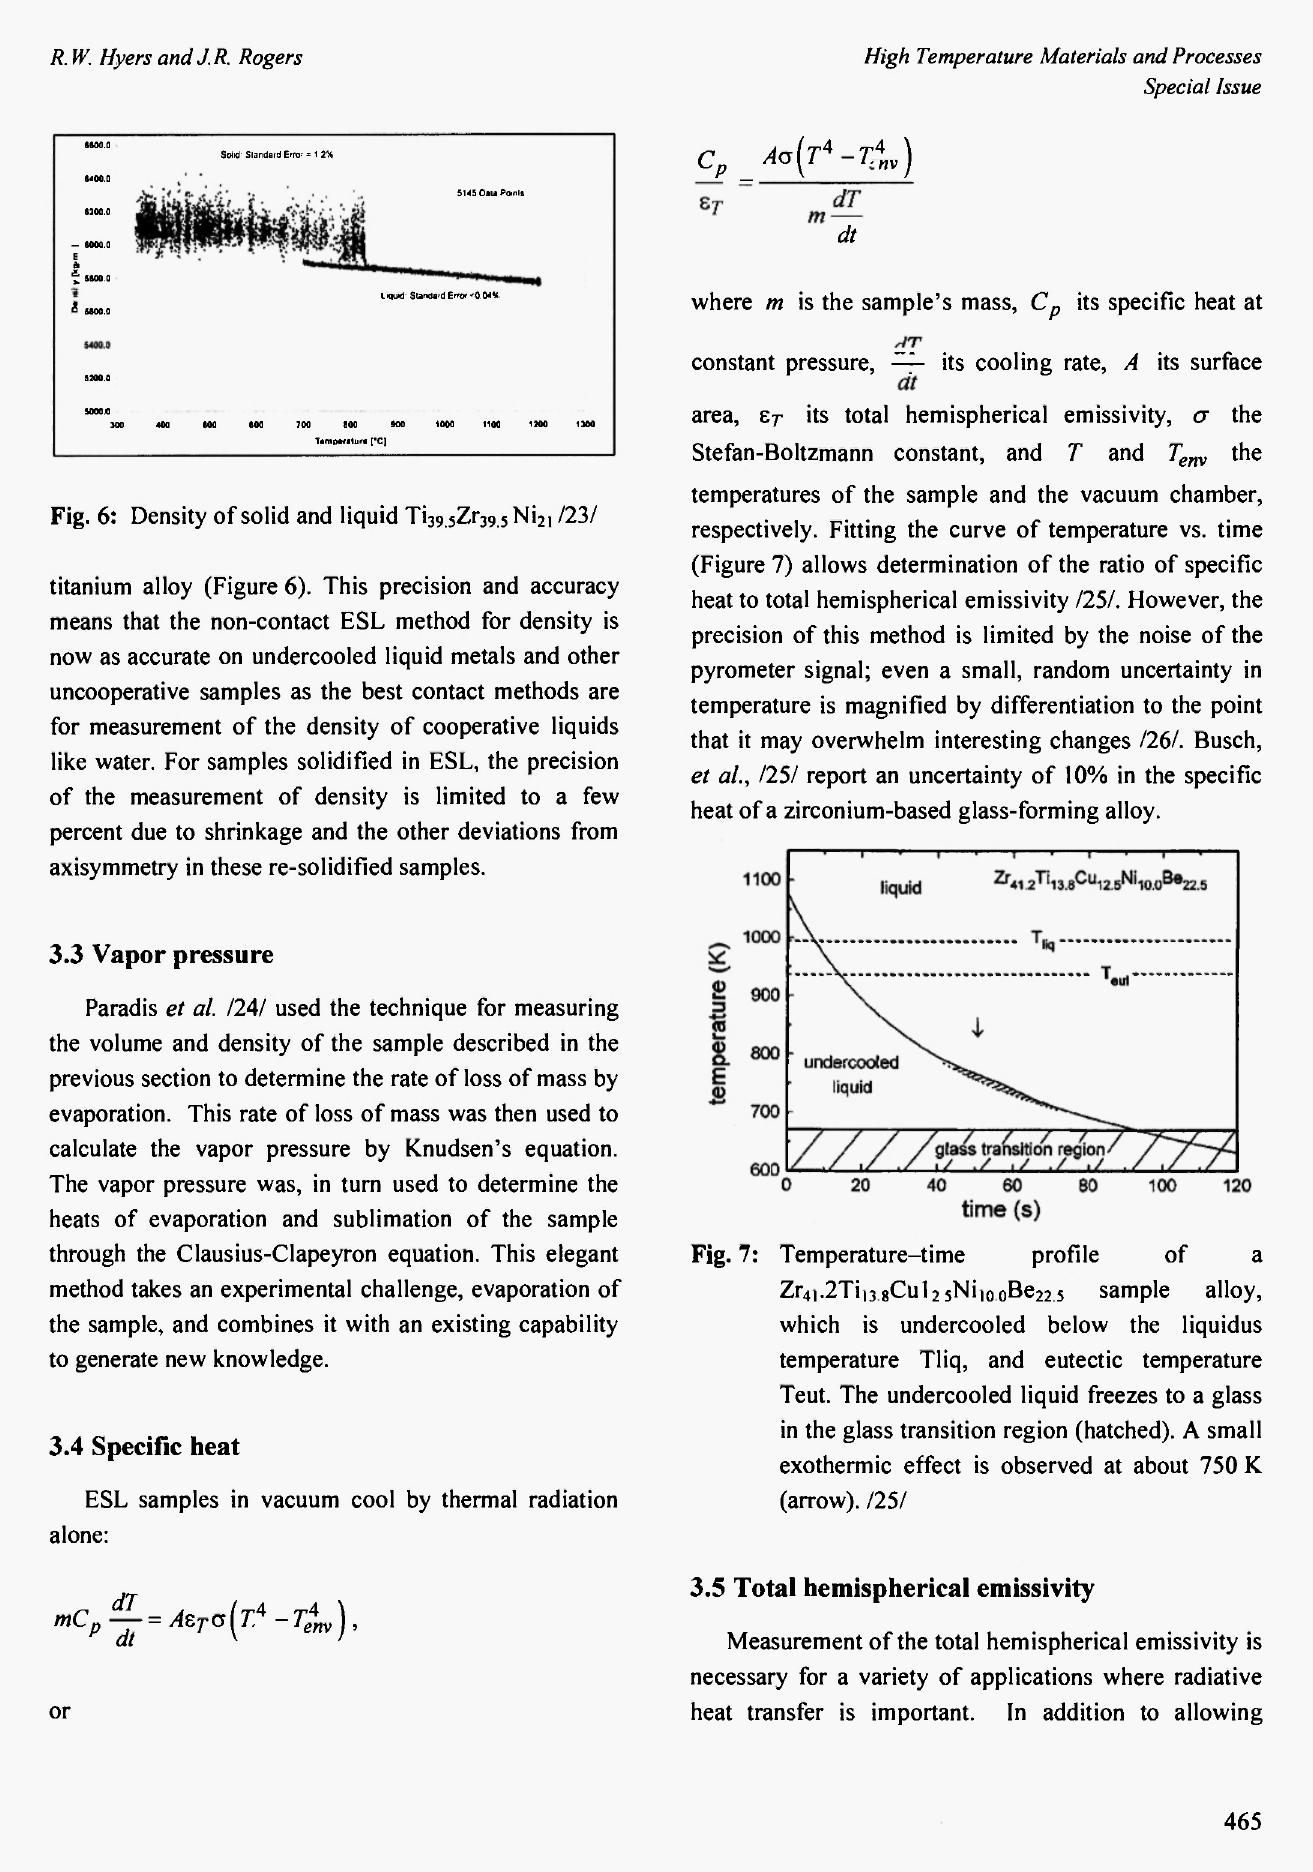
3.5 Total hemispherical emissivity Measurement of the total hemispherical emissivity is necessary for a variety of applications where radiative heat transfer is important. In addition to